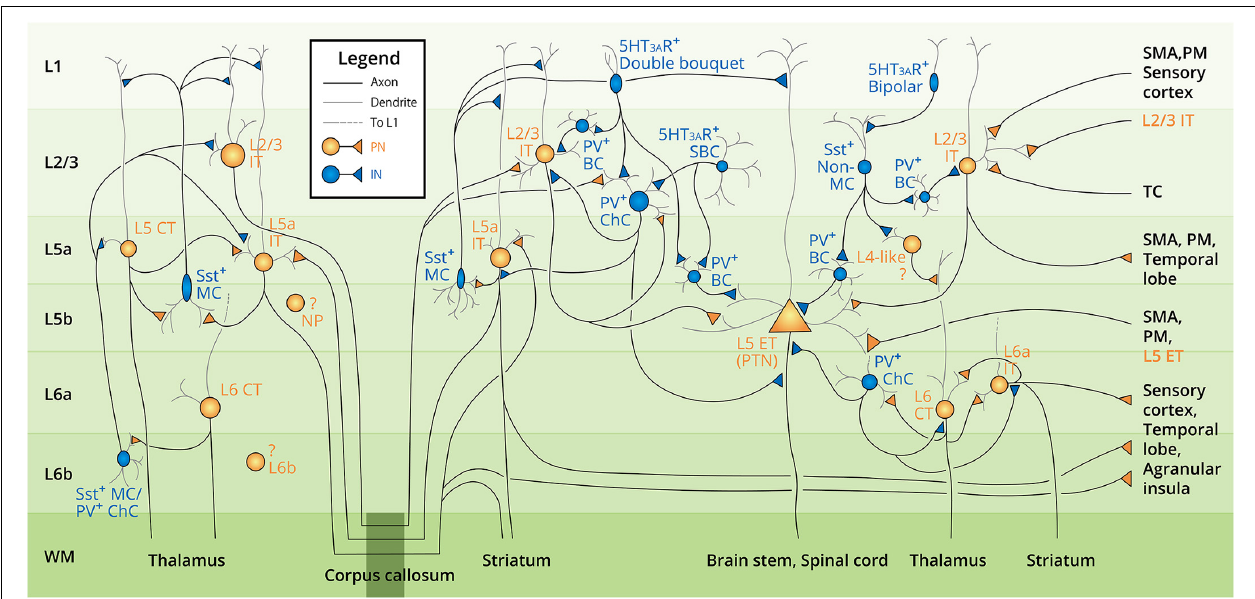
FIGURE 2 | Summarized diagram of motor cortex neocortical neuron landscape and circuit connectivity. Neuron subtypes are labeled next to the cell soma from layer 1 to layer 6b (L1–L6b, labeled at the left side of the diagram), with the text color corresponding to the neuron type (orange–excitatory pyramidal neuron, PN; blue–inhibitory interneuron, IN). Gray lines denote the dendrites; black lines denote the axons. The target of the descending axons is indicated in the white matter (WM) area. Intracortical and interhemispheric connections are denoted by the division of the corpus callosum (dark green box at the bottom of the diagram). Note that all the neurons and connections are presented in both hemispheres. The question mark denotes the unclarified connectivity of the corresponding neurons. Abbreviations of the neuron subtypes can be found in Figure 1 . Other abbreviations: MC, Martinotti cell; ChC, chandelier cell; BC, basket cell; SBC, small basket cell; PTN, pyramidal tract neuron; SMA, supplementary motor cortex; PM, premotor cortex; TC, thalamocortical